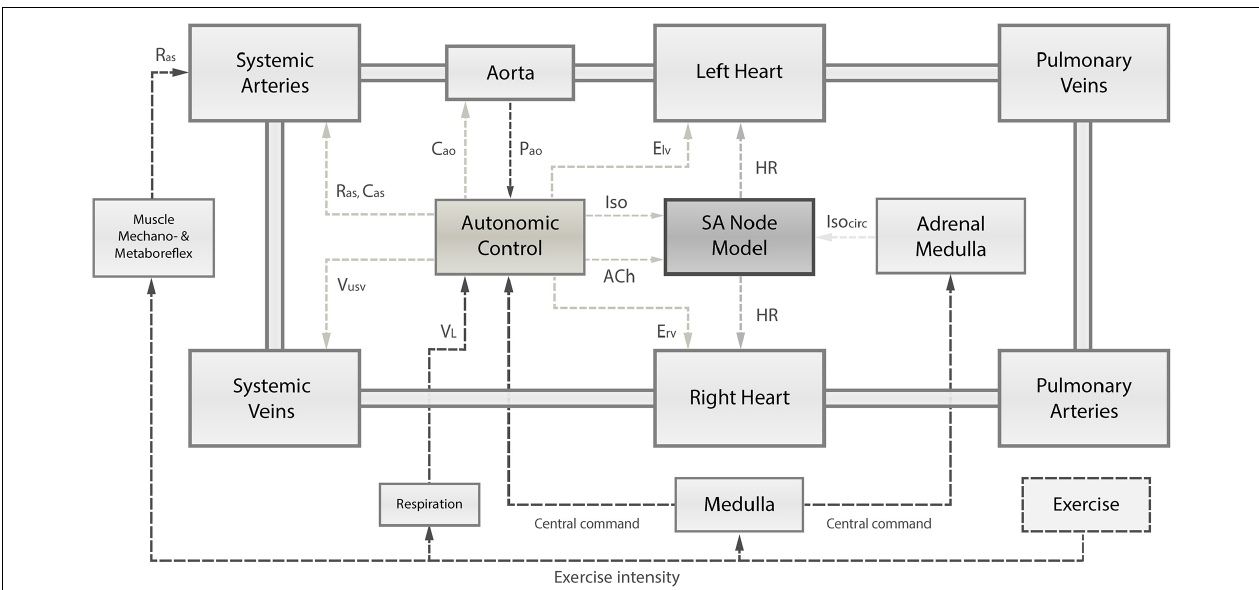
FIGURE 1 | Schematic overview of the integrated numerical model, comprising (1) the cardiovascular system and its principal compartments; (2) the single-cell SA node model; and (3) the autonomic control governed by arterial baroreflex and pulmonary stretch reflex integrating receptor information on instantaneous aortic pressure ( P ao ) and instantaneous lung volume ( V L ). Based on autonomic activity, the SA node depolarization rate is modulated through changes in acetylcholine (ACh) and isoprenaline (Iso) concentrations. Autonomic control has also influence on the left and right ventricular contractility ( E lv , E rv ), systemic vascular resistance ( R as ), and systemic venous unstressed volume ( V usv ). Muscle mechanoreflex and metaboreflex modulate Ras to account for vasodilation in response to exercise. Exercise intensity determines the level of central command, respiration frequency, and muscle mechanoreflex and metaboreflex activity. Ultimately, the central command has a direct influence on autonomic control loops and the adrenal medulla releasing catecholamines (Iso circ